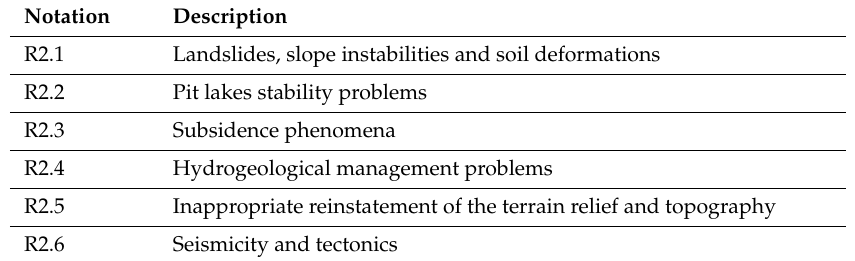
Table 2. Surface Lignite Mines Restoration Technical Geological and Geotechnical Risks